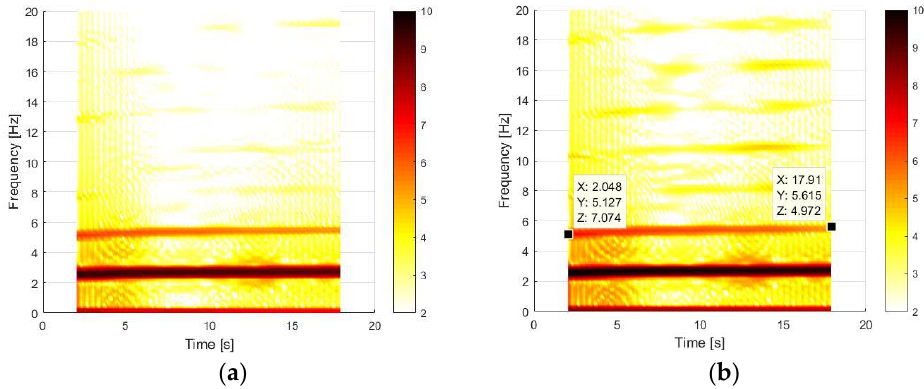
Figure 11. Time – frequency contents of MaD test for P11 (magnet) ( a ) and P14 (mass) ( b ) profilome- ter points.